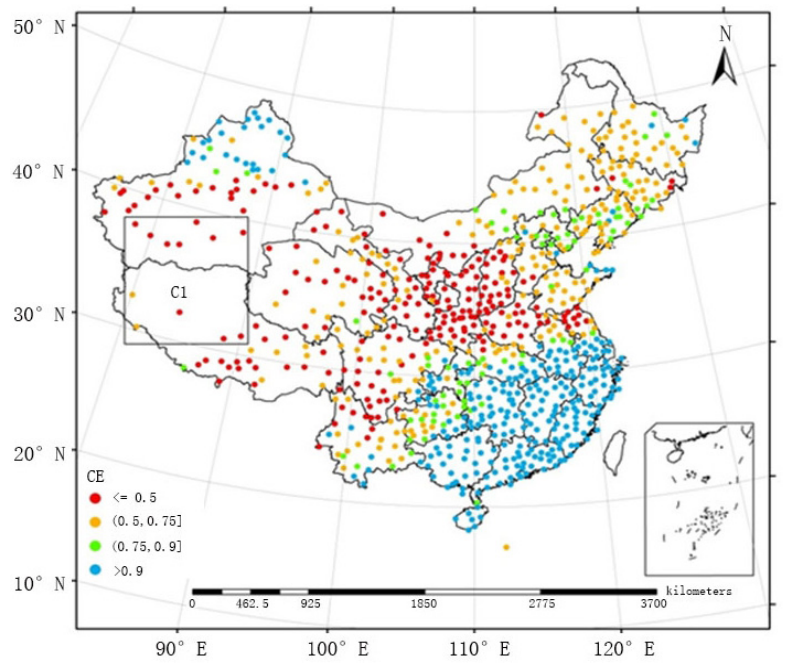
Figure 5. Spatial distribution of the CE obtained by FMS between May and September from 2005 to 2010.